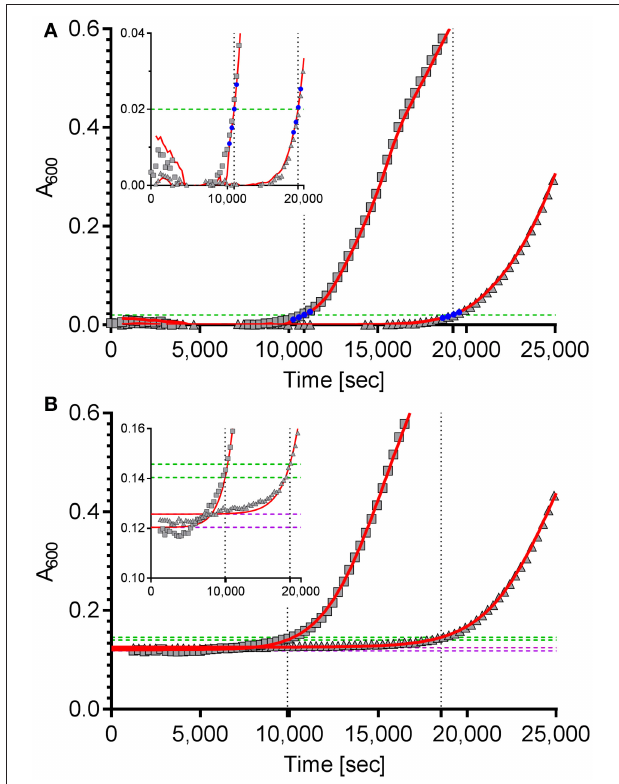
FIGURE 1 | Calculation of the time to reach the threshold of 1 A 600 = 0.02 of two example growth curves using two different curve fitting and normalization methods. (A) The “R” package “chipPCR” was used to analyze the raw data (gray squares and triangles). After subtraction of a background function, the curves were fit using the moving average (mova) function (red lines). To calculate the time to reach the threshold of 0.02 (dashed green line), the point of intersection with a linear regression of four data points (blue) near the threshold was used. Here, threshold times of 10,874s and 19,243s (dotted black lines) were determined. (B) The same raw data sets shown in (A) were fit to a 5-parameter log-logistic function implemented in the “R” package “drc” (red lines). The thresholds of 1 A 600 = 0.02 were calculated individually for each data set (dashed green lines) by adding up 0.02 to the lower asymptotes (dashed purple lines) of the log-logistic functions. Threshold times of 9,890s and 18,534s were calculated from the intersection points (dotted black lines). Insets: zoomed views of the data ranges showing the transition to logarithmic growth.